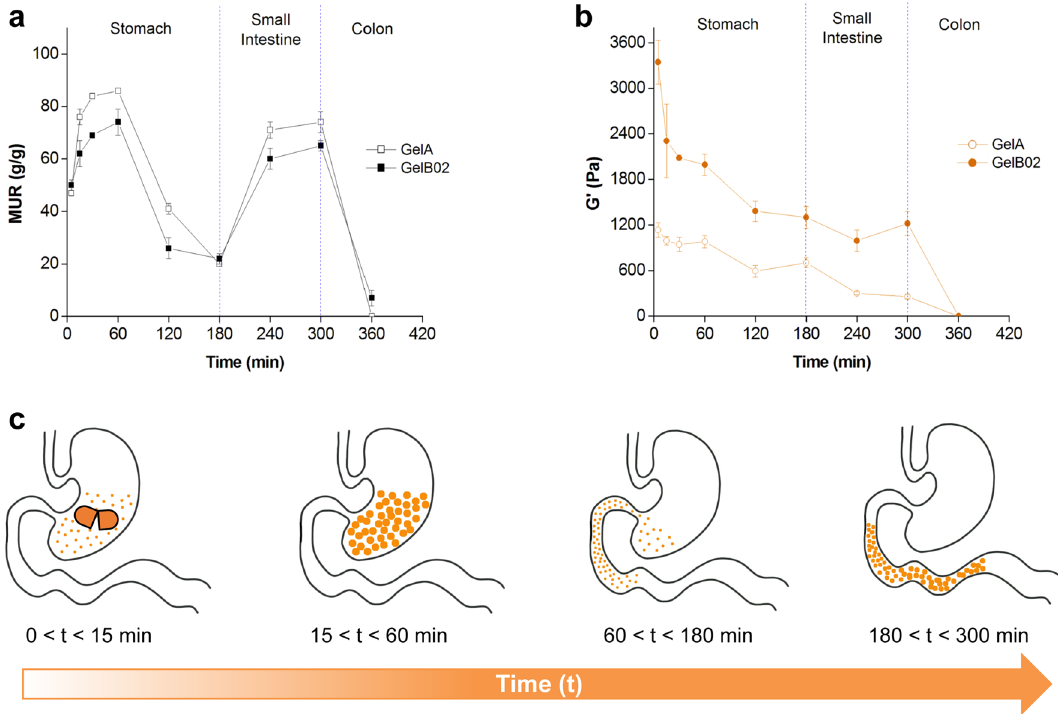
Figure 4. CB-SAHs absorption (MUR) and elasticity (G ′ ) in simulated GI conditions. ( a ) Variations of MUR and ( b ) elastic modulus G ′ of GelA and GelB02, as assessed by the in vitro simulated GI model (n = 3 at each time point, mean ± SD; plots produced with Origin 6.0, www. origi nlab. com). ( c ) Graphical sketch of a CB-SAH hydrating in the stomach and then traveling through the intestine, as simulated by the in vitro model here